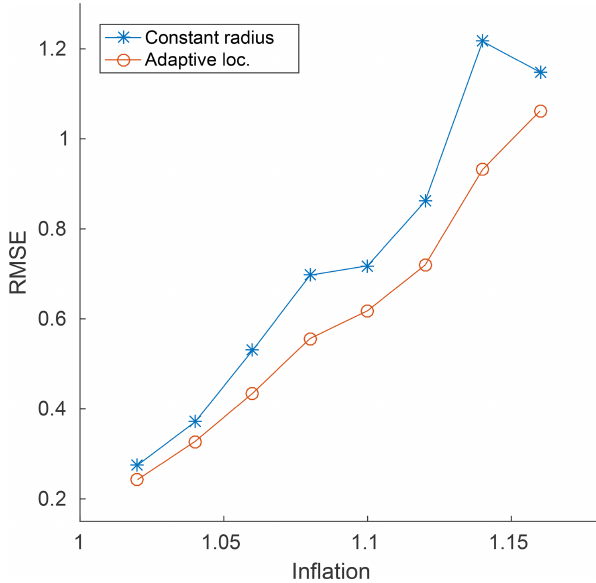
Figure 8. Quasi-geostrophic model adaptive localization. The in- flation factor is kept constant, and α values from 1.02 to 1.16 are represented on the x axis. The constant localization radius varies in increments of 5 over the range [ 5 , 45 ] . Only the best results are plotted, and they are used as the mean seeds for the adaptive algo- rithm. For the adaptive case we vary the parameters ¯ υ by taking one of three possible values, differing from the optimal constant radius by − 5, 0, and + 5. The adaptive Var (υ) takes one of the values 1 / 2, 1, 2, and